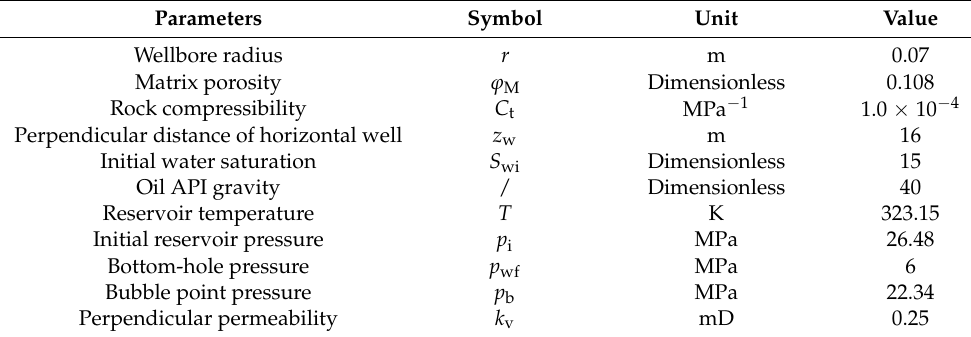
Table 2. Basic parameters used for the sensitivity analysis.